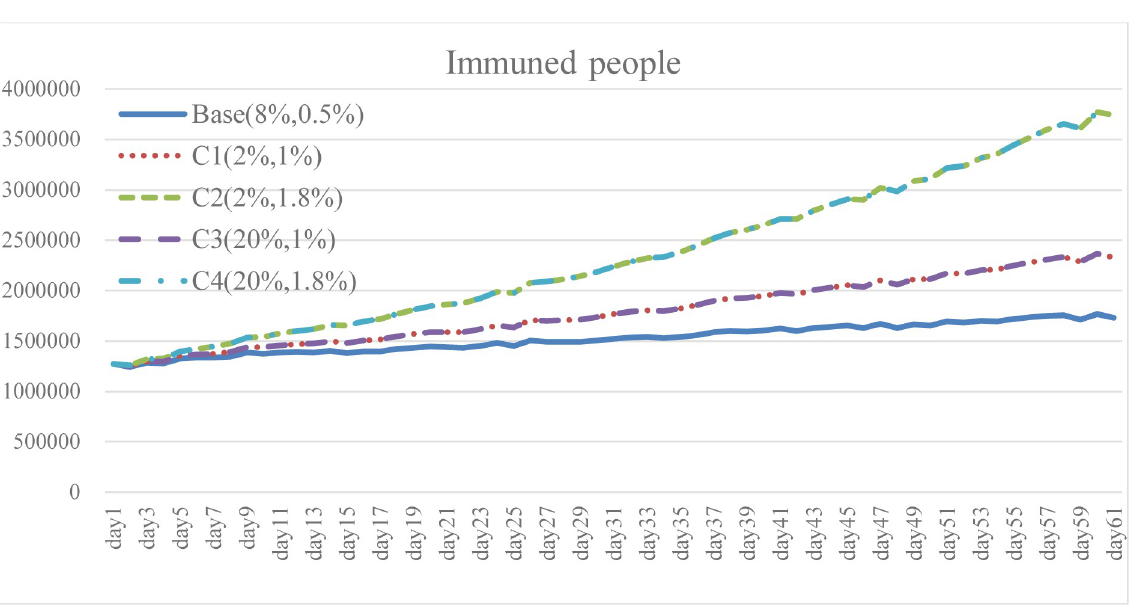
person-to-person contacts and government efforts to help mitigate the negative effects of the pandemic. This model is likely to be limited to the United States, as vaccines vary in variety and effectiveness in other regions and countries, as well as in government policy patterns and pandemic responses. The frequency of contact between people in isolation is highly uncertain.